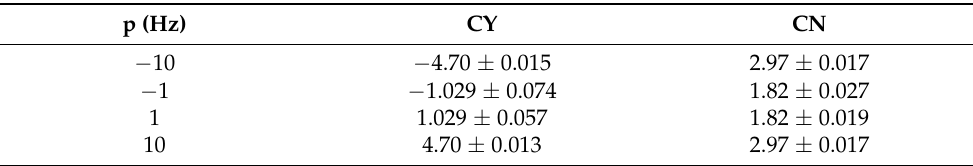
Table 5. Averaged side and normal force coefficients versus spin velocity at Ma = 0.2, Re = 2 × 10 6 and α = 20 degrees.